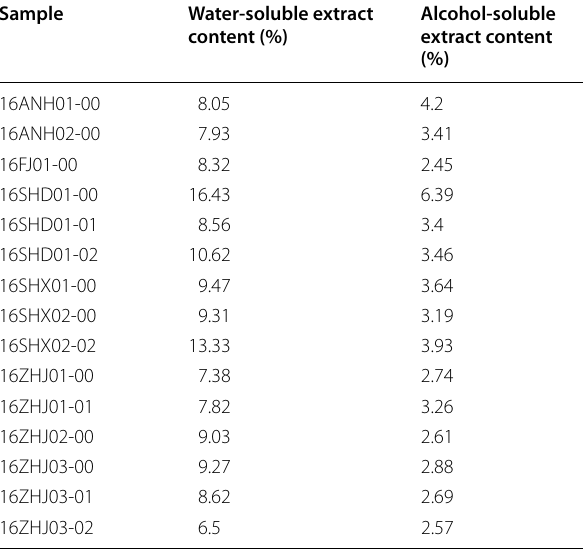
Table 1 The content of moisture and total ash Sample